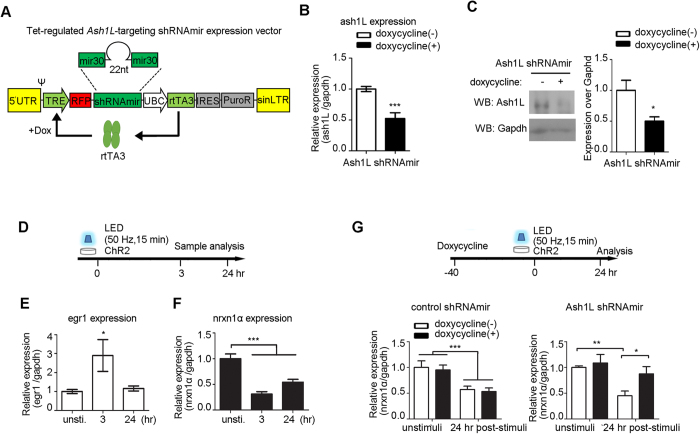
Knockdown of Ash1L reduced neuronal activity-induced repression of nrxn1α.(Α) Τhe design of doxycycline-inducible shRNAmir against Ash1L. The transcription of shRNAmir and TurboRFP are under the control of the tetracycline response element (TRE) promoter, which can be activated by the reverse tetracycline transactivator 3 (rtTA3) in the presence of Dox. (B,C) Reduction of mRNA Ash1L (n = 3 each group; Student’s t-test, ***P < 0.001) and protein levels (full-length blots in Fig. S4; n = 4 each group; Student’s t-test, *P < 0.05) 48 hours after induction in NG108-15 cells. (D–F) Optogenetic stimulation induced expression changes of egr1 (E) and nrxn1α (F) in differentiated NG108-15 cells. Real-time PCR was performed for quantification (n > 6 biological samples, one-way ANOVA with Dunnett’s post hoc test, *P < 0.05, ***P < 0.001). (G) The activity-dependent repression of nrxn1α was rescued by the Dox-induced knockdown of Ash1L knock-down cells (n > 5; two-way ANOVA with Bonferroni post hoc test, *P < 0.05, **P < 0.01, ***P < 0.001).